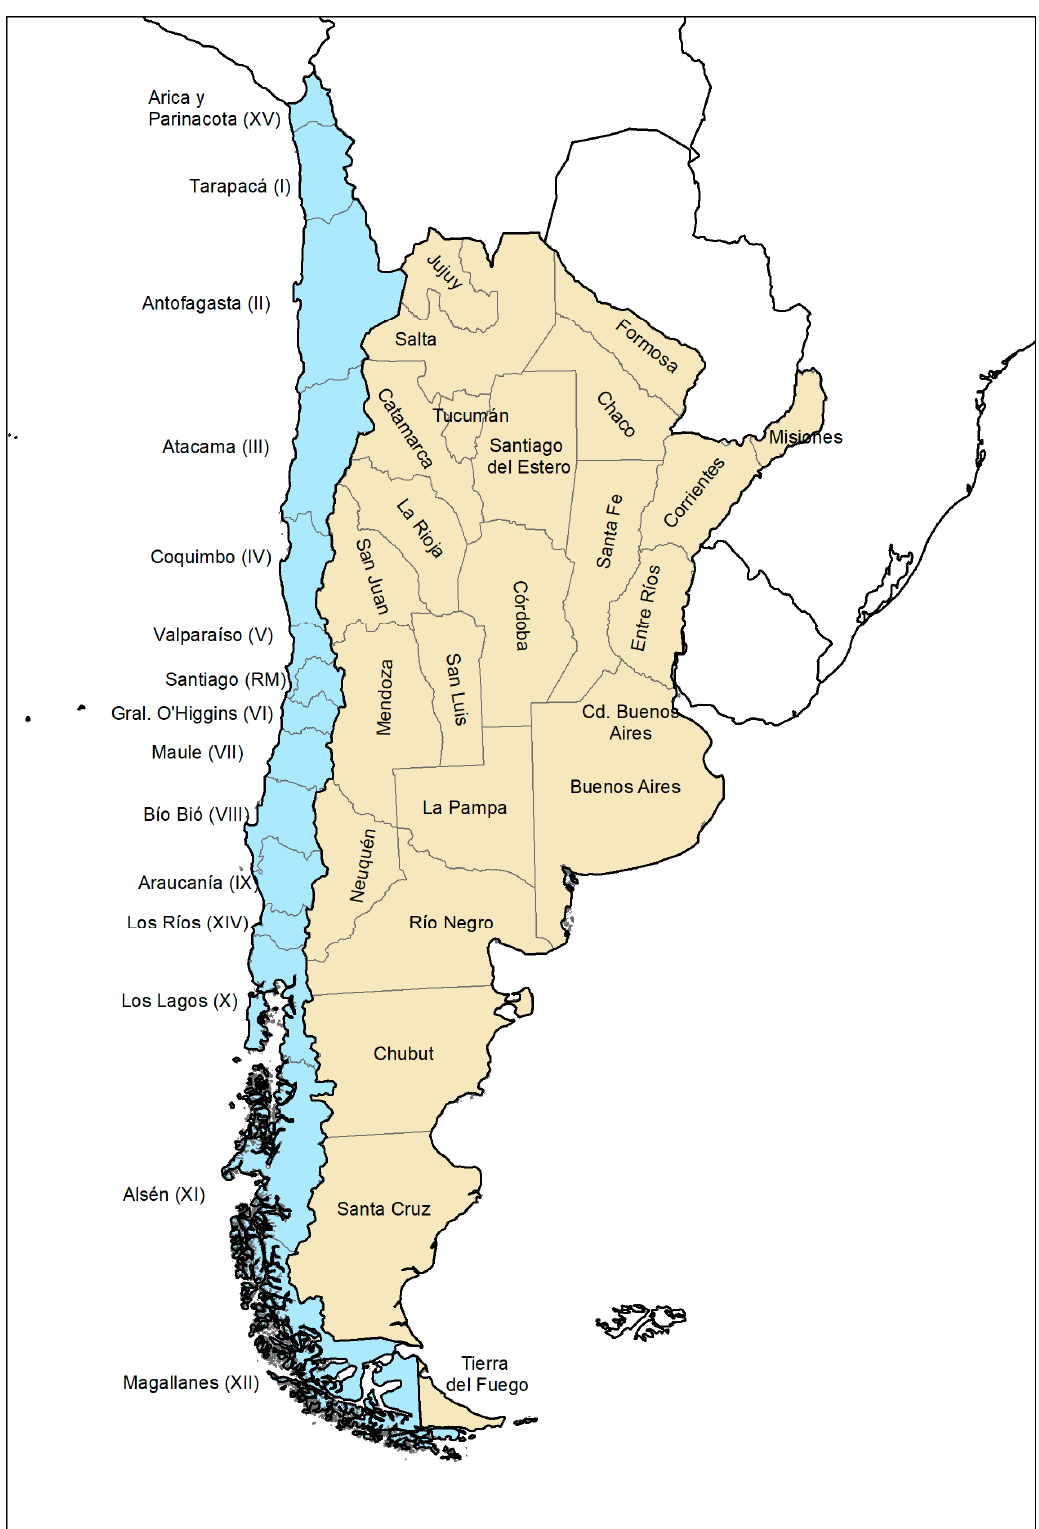
Figure 1. Map of Chile and Argentina, with province names and numbers for Chile, prepared by T. H. Atkinson.